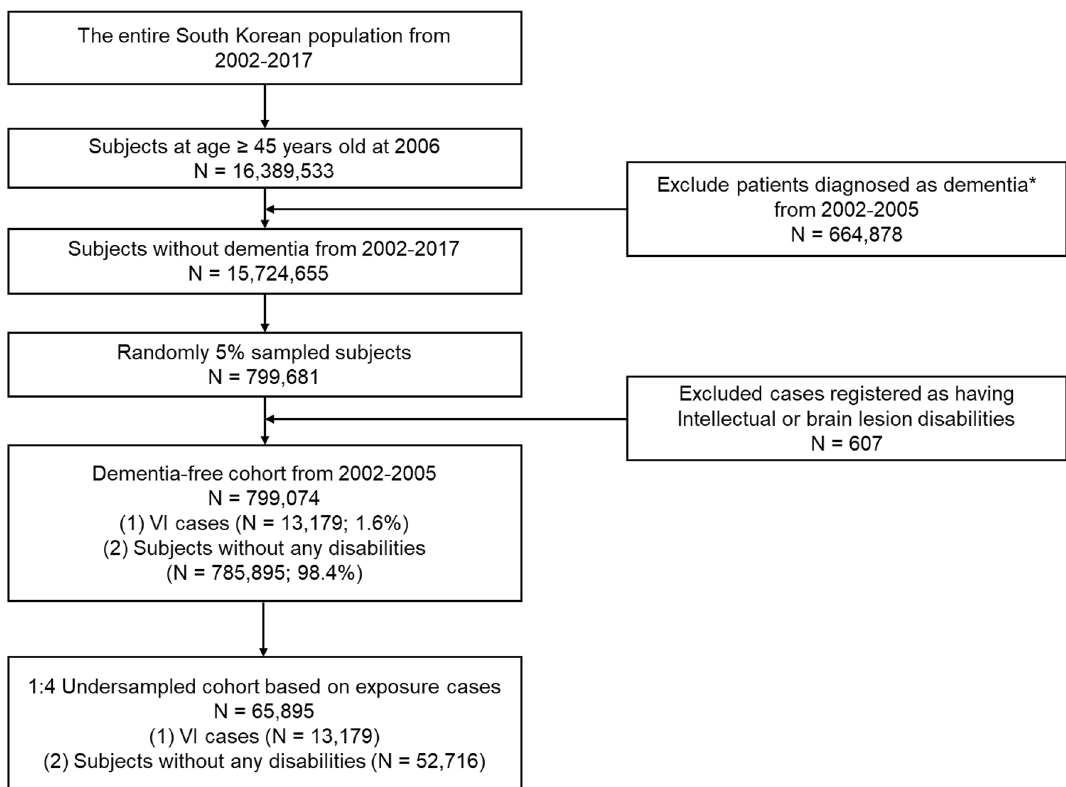
G30, F05, or G31) and medication prescriptions [acetylcholinesterase inhibitors (donepezil, galantamine, rivastigmine) or NMDA receptor antagonists